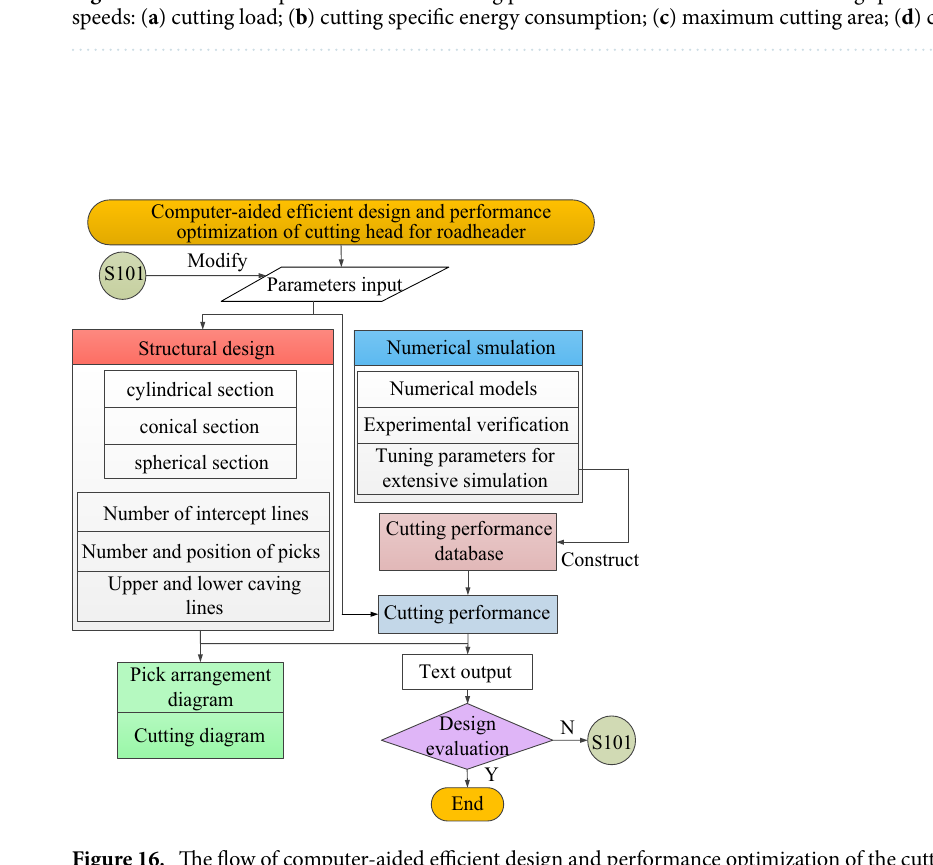
Figure 16. The flow of computer-aided efficient design and performance optimization of the cutting head for